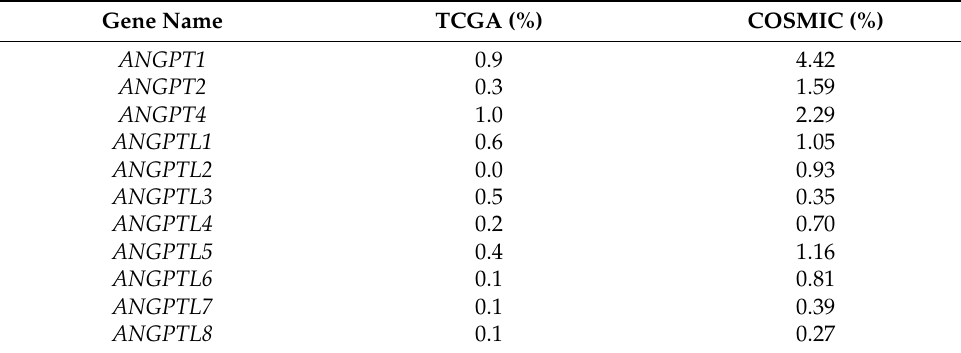
Table 1. Mutation frequencies of ANGPT / ANGPTL genes in breast